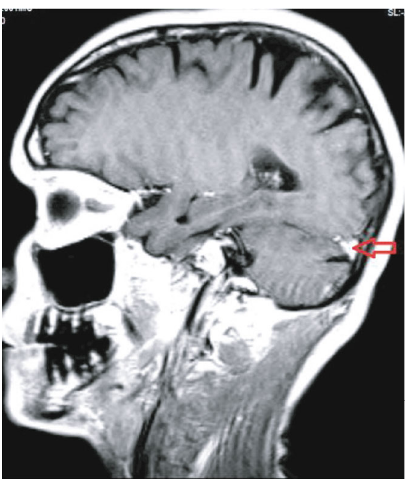
Figure 1: Patient MRI in sagittal view. Demonstrates calci fi cations in the supratentorial cerebellum.